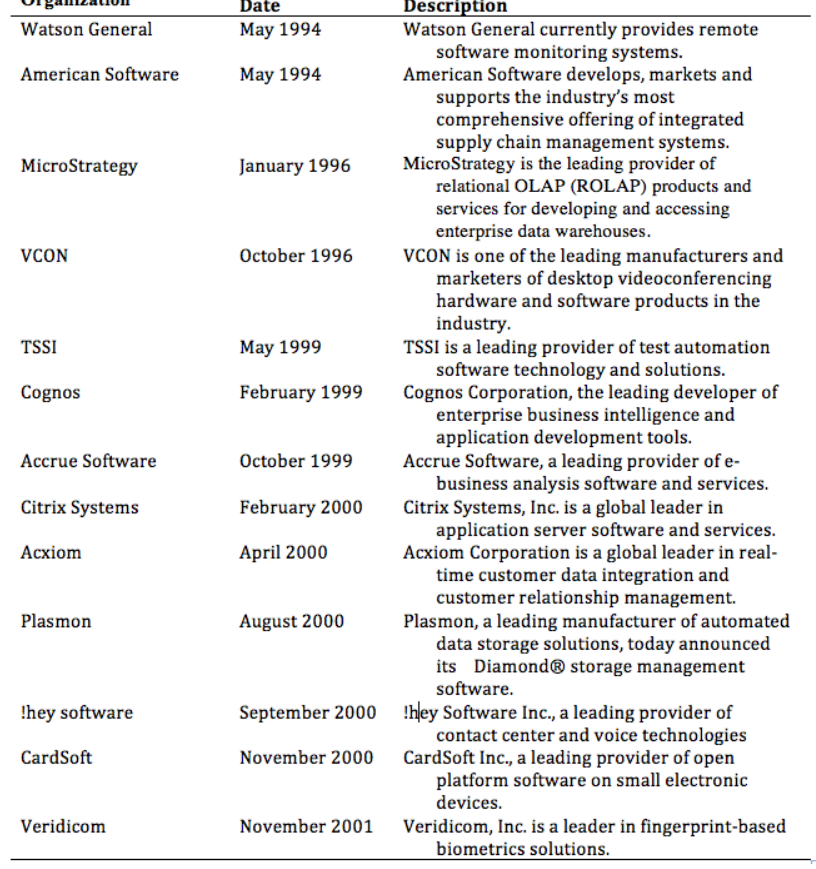
Figure 4: Sample press release identity statements with category